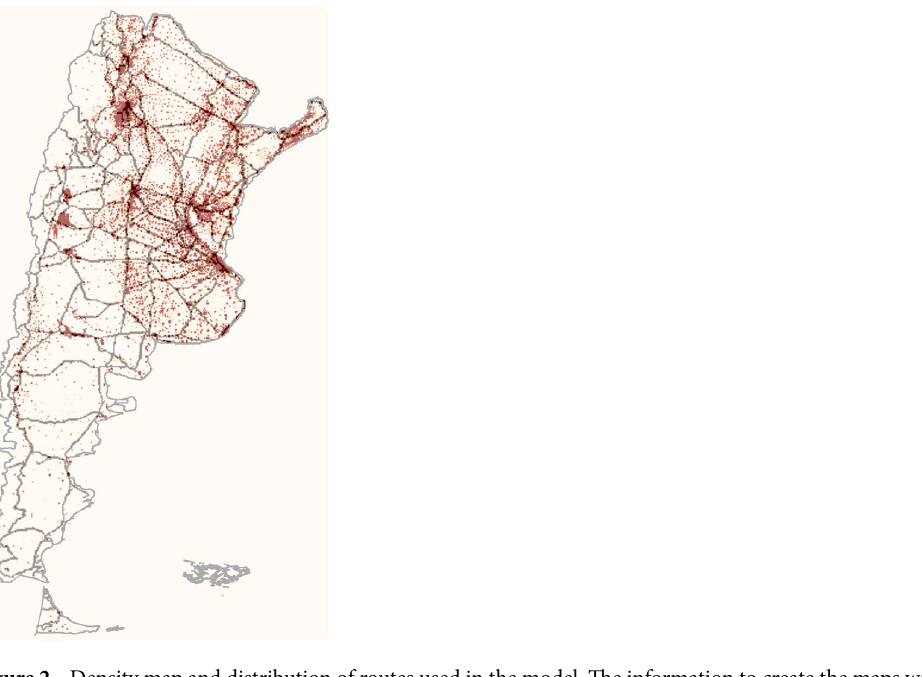
Triggers the dynamic in a new cell. Corresponds to start the disease in a city with at least 10 infectedpeople